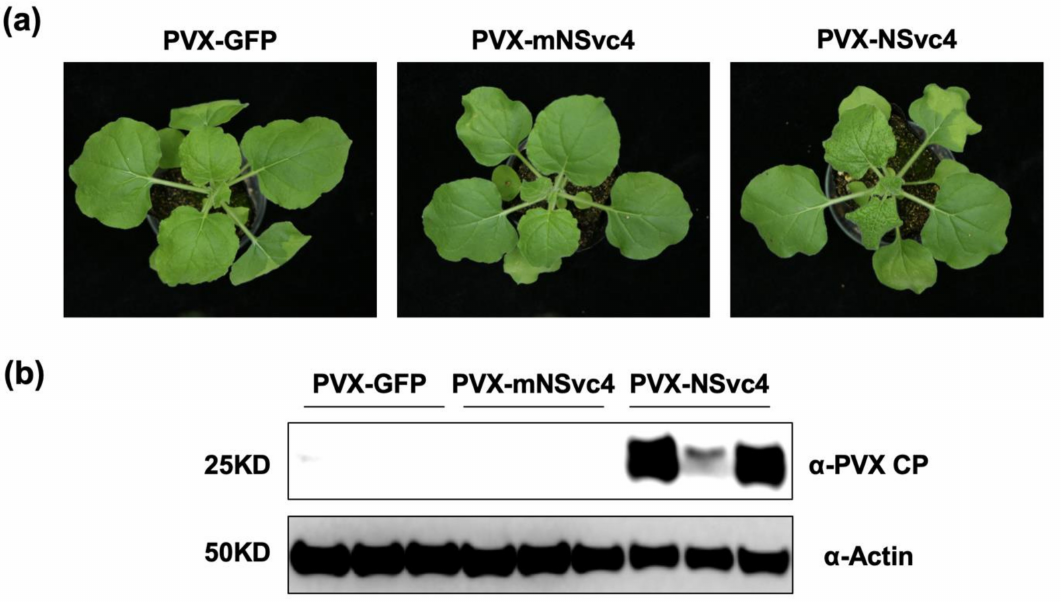
Figure 3. PVX-mediated expression of NSvc4 promotes PVX infection. ( a ) Symptoms elicited by PVX expressing GFP, mNSvc4, and NSvc4 at 5 dpi. ( b ) Western blotting of N. benthamiana leaves infected with PVX-GFP, PVX-mNSvc4, and PVX-NSvc4 to detect PVX accumulation by using anti-PVX CP antibodies. Actin was used as a loading